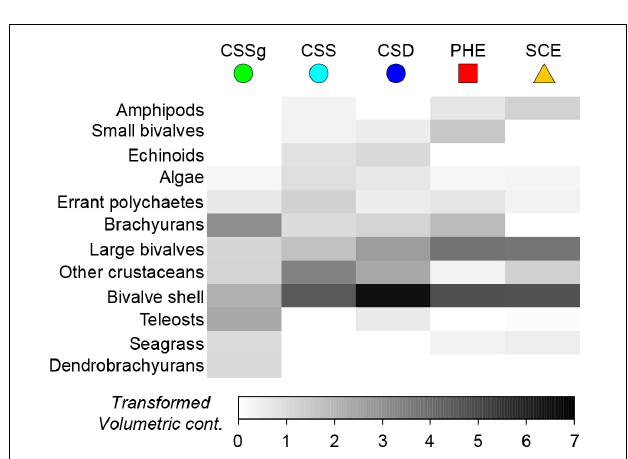
FIGURE 3 | Two-dimensional metric Multidimensional Scaling (mMDS) ordination plot constructed from bootstrap averages of the dietary composition of Portunus armatus in each location during the Austral summer. Group averages (larger black symbols) and approximate 95% region estimates fitted to the bootstrap averages (shaded areas) are shown.